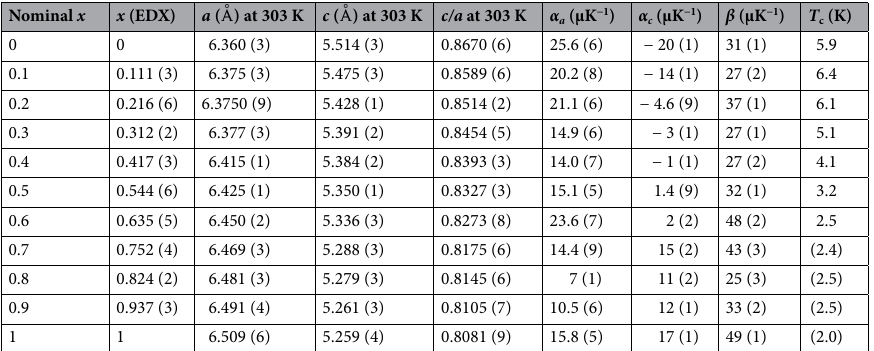
Table 1. Results of chemical analyses, evolutions of lattice constants and thermal expansion constants, and T c in examined Co